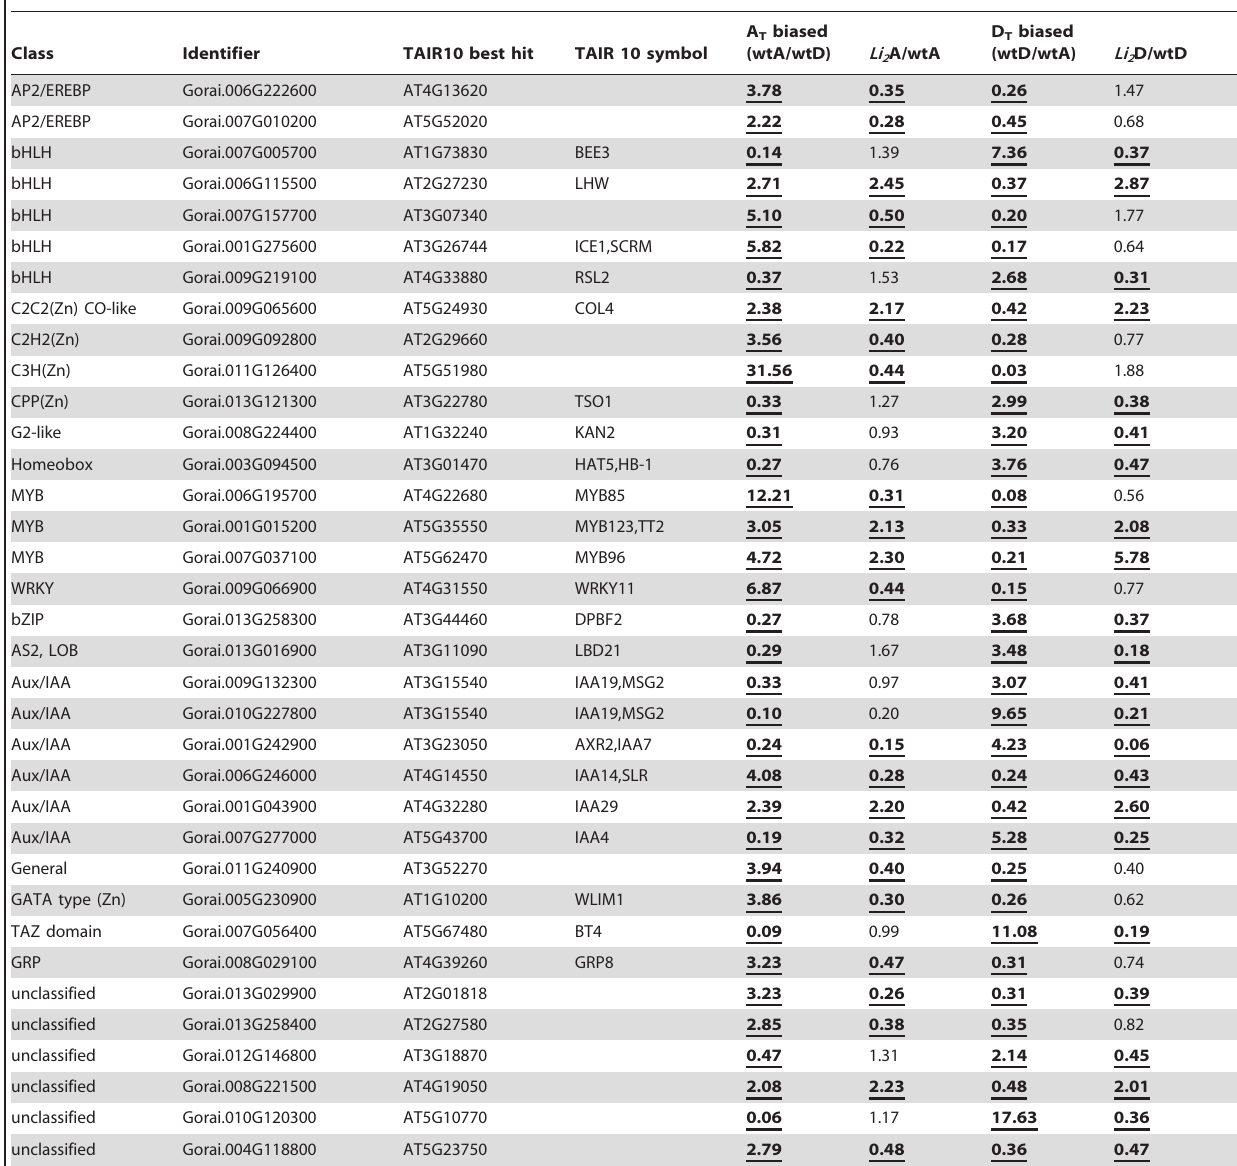
Table 3. Subgenome biased transcriptional regulators affected by